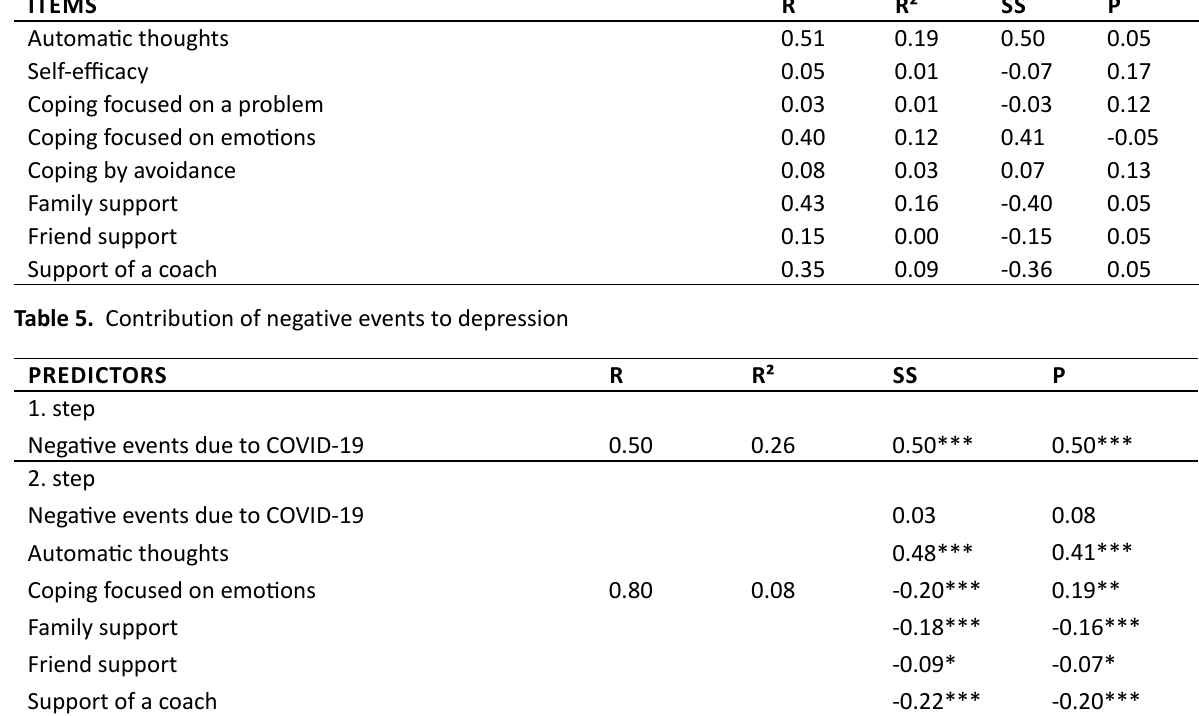
Table 4. Contribution of a to the criterion ITems